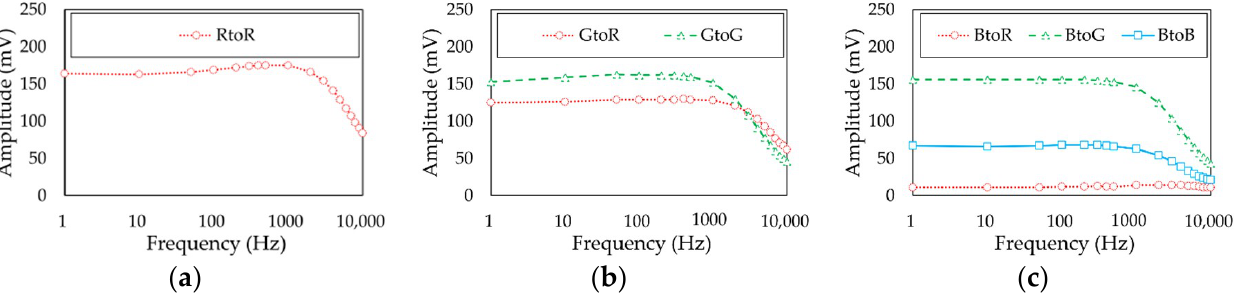
Figure 7. Frequency response of the channel when the transmitter is ( a ) red, ( b ) green, and ( c )